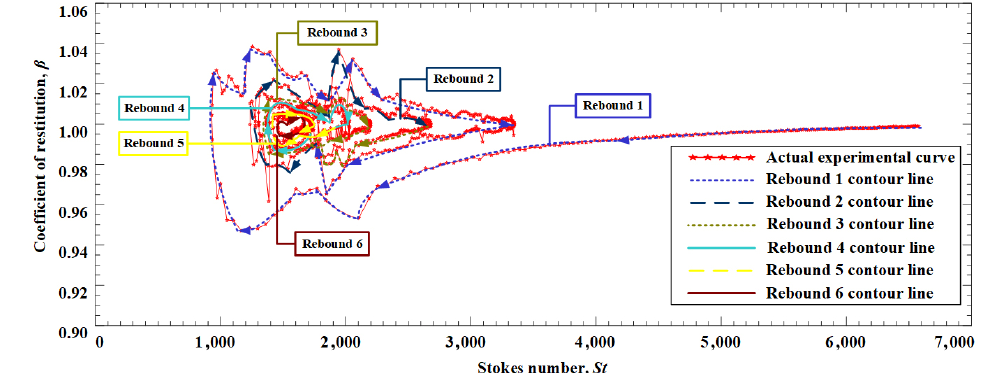
Fig. 7 Coefficient of restitution β vs. Stokes number St of water drop impacting dragonfly wing